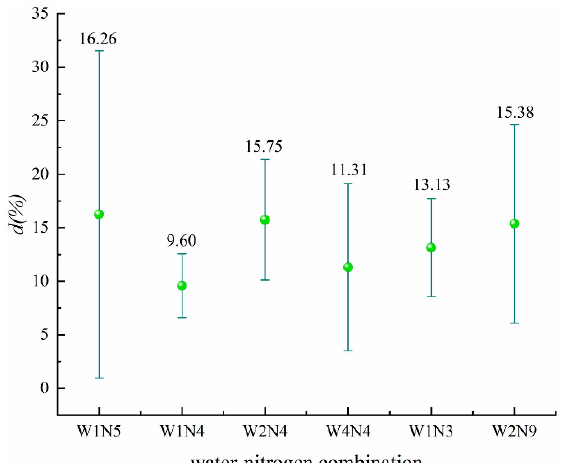
Figure 3. ( a ) Effect of different irrigation schedules on nitrogen use efficiency ( p = 0.01682); ( b ) effect of different nitrogen application levels on nitrogen use efficiency ( p = 0.03588).